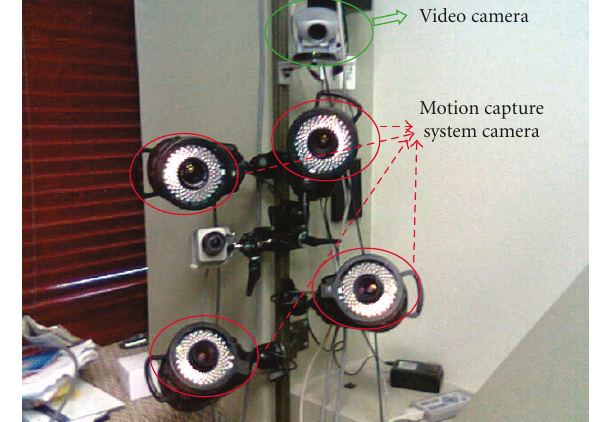
Figure 13: Setup for collecting groundtruth data with Vicon sys- tem. Cameras in red circles are Vicon infrared cameras, and the camera in green circle is the video camera for collecting testing se-